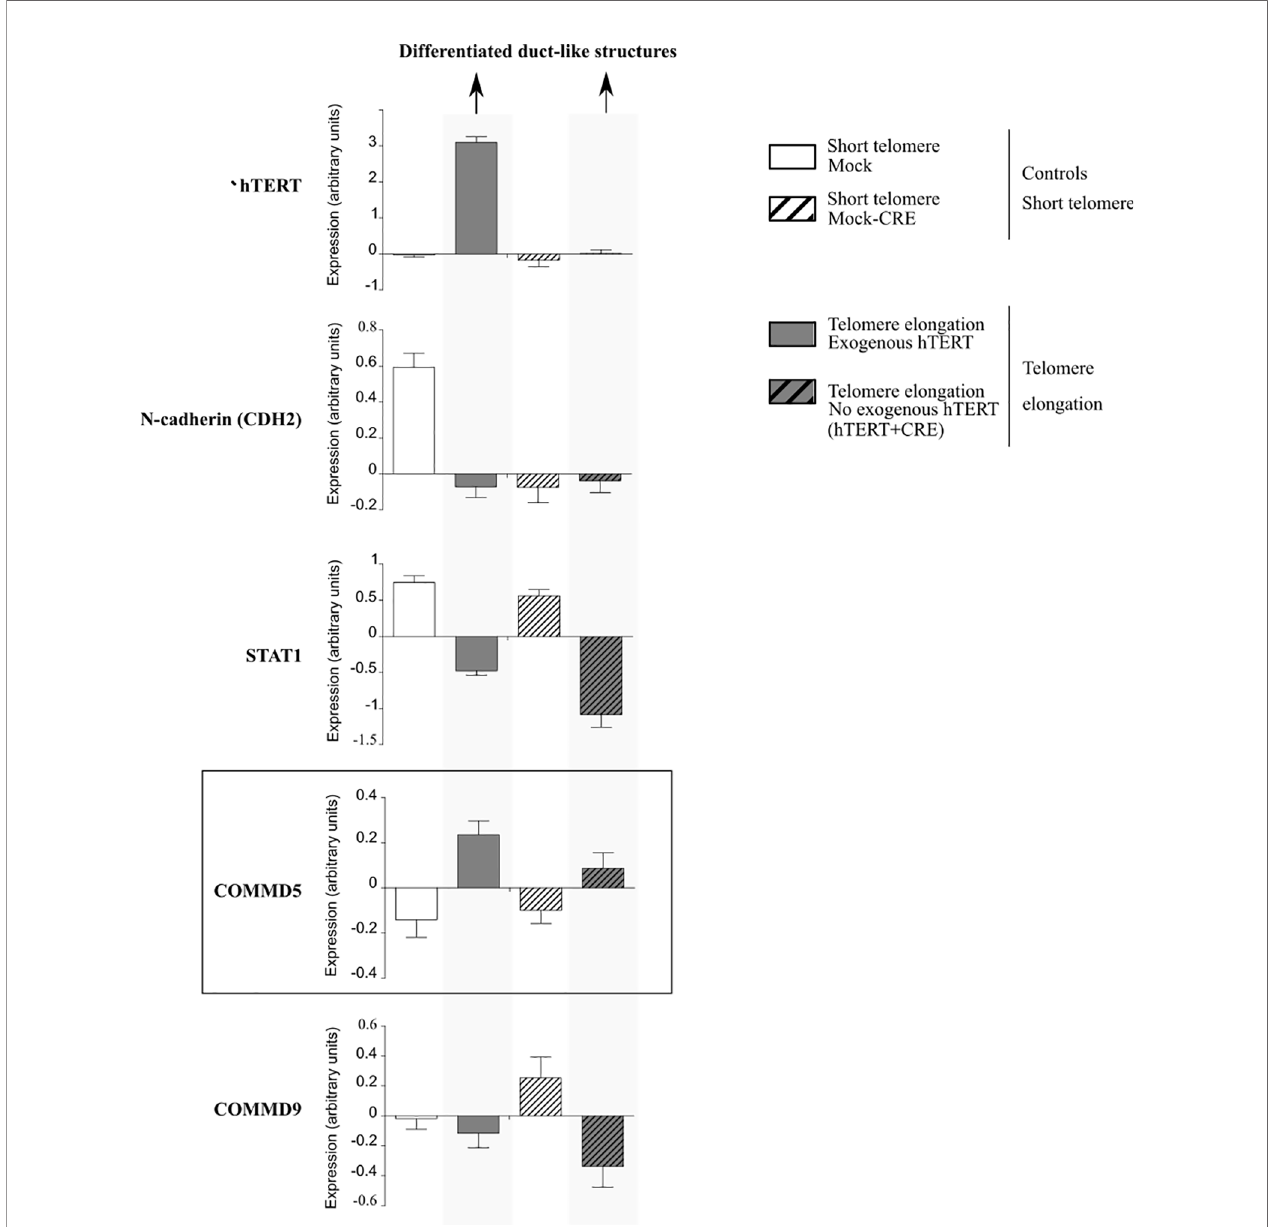
FIGURE 5 | Analysis of mRNA expression pro fi les in PC-3 prostate cancer cells in the presence of exogenous human telomerase reverse transcriptase (hTERT). Forced elongation of telomeres correlated with COMMD5 expression. Data were extracted from the geopro fi le database (GSE41559), plotted in an excel fi le and analyzed. Hirashima et al. (62) established a PC-3 sub-line that overexpressed exogenous hTERT (hTERT) and upregulation of telomerase activity and substantial telomere elongation in these PC-3/hTERT cells was compared with control cells (Mock). To examine whether the formation of the duct-like structures resulted from telomere elongation and not from increased levels of hTERT protein, they removed the hTERT transgene after telomere elongation using the Cre/ loxP system. They added the loxP sequence at both the 5 ′ and 3 ′ ends of the wild-type hTERT cDNA and established the stable PC-3/LhTERTL cell line (hTERT+CRE) or control cells (Mock-CRE). They subcutaneously injected these four PC-3 cell lines, mock, hTERT, mock-CRE, and hTERT+CRE, into nude mice and collected the resultant xenograft tumors to monitor gene expression that might be important for differentiation of PC-3 cells in vivo using a microarray approach. Forced elongation of telomeres in cancer cells promotes PC-3 cell differentiation and the mRNA expression of N-cadherin , STAT1 and COMMD5 but not COMMD9